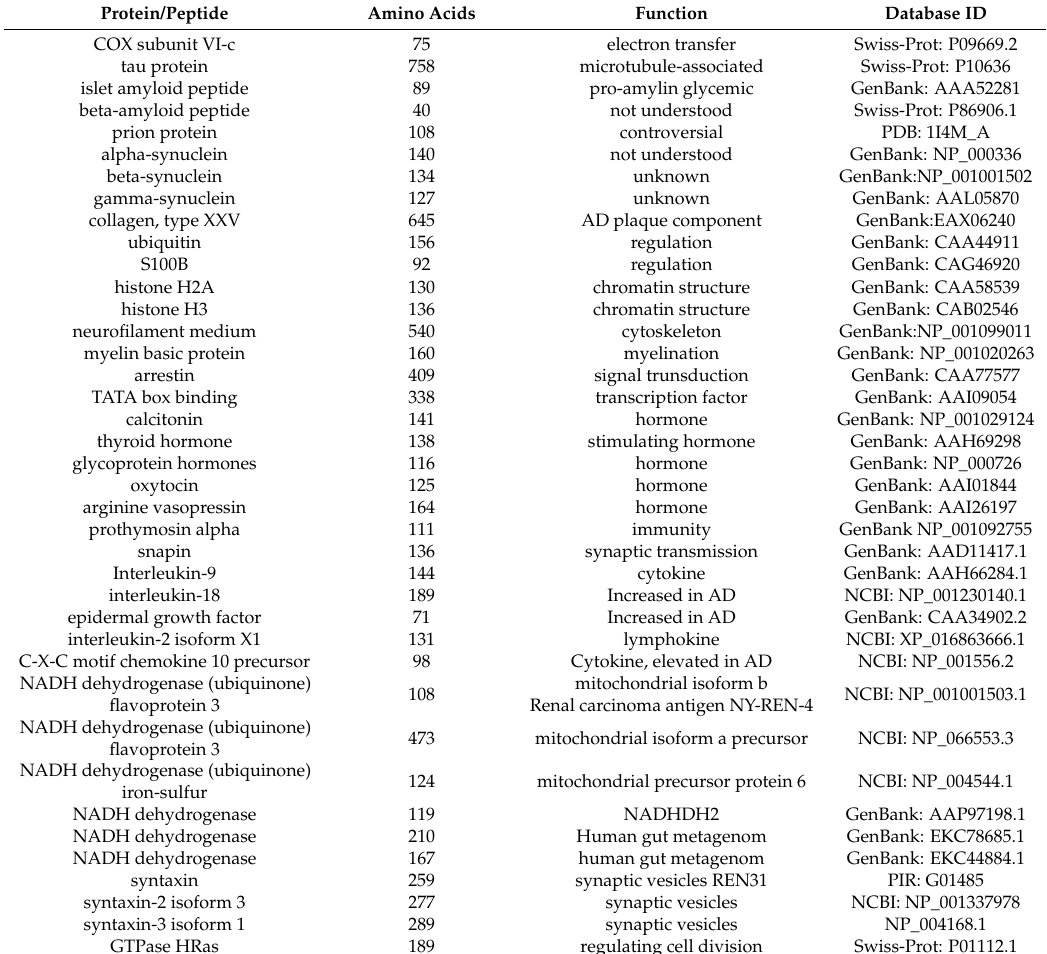
Table 3. Human Trp-free proteins and